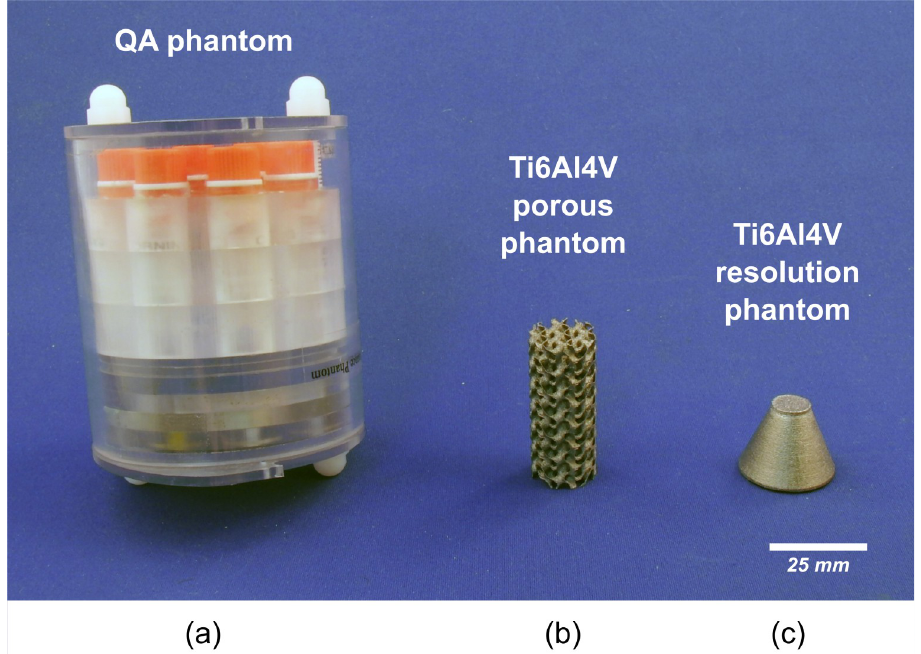
Fig 5. Physical appearance of the imaged phantoms for this study. (a) comprehensive quality assurance CT phantom, (b) porous, gyroid-based, cylindrical, titanium-alloy (Ti6Al4V) phantom, and (c) titanium-alloy (Ti6Al4V) resolution